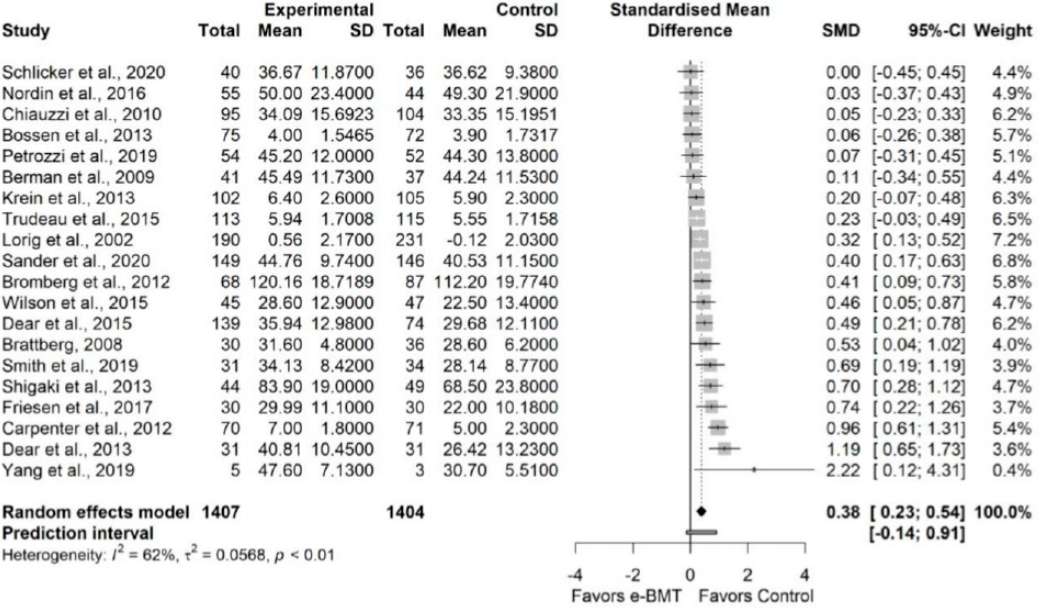
Figure 6. Sensitivity analysis of self-efficacy for online behavioral techniques against usual care or waiting list. The forest plot summarizes the results of included studies (sample size, mean, standard deviation (SD), standardized mean differences (SMDs), and weight). The small boxes with the squares represent the point estimate of the effect size and sample size. The lines on either side of the box represent a 95% confidence interval (CI).